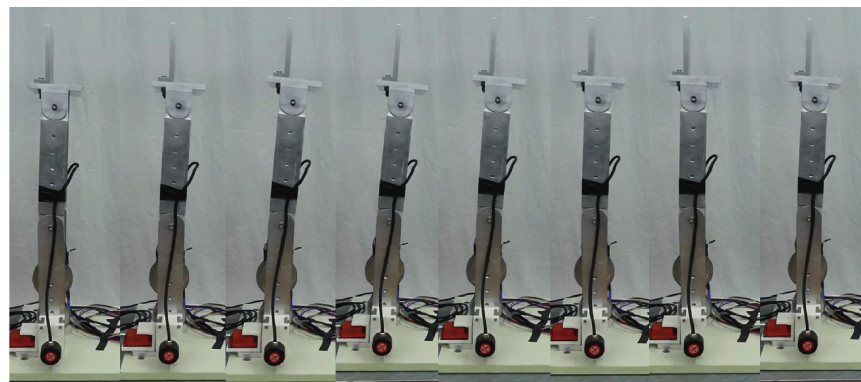
Figure 9: Standing balance process of the bipedal robot.